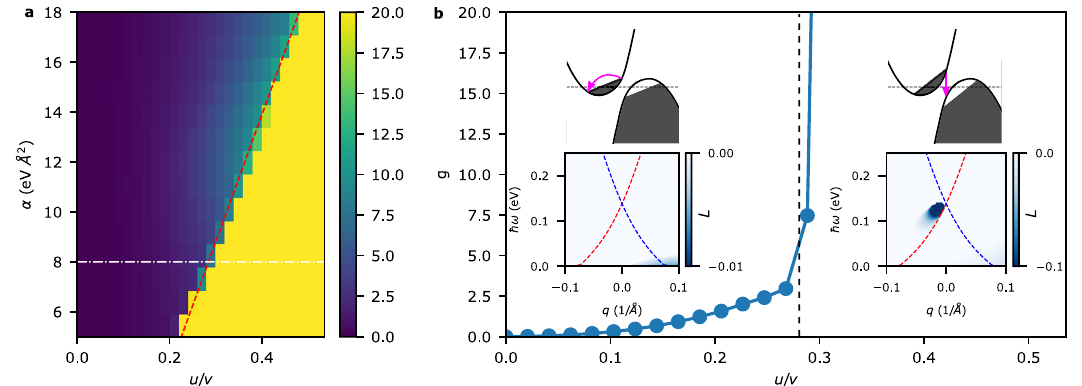
transitionsresponsiblefor u / v =0.165and u / v =0.33whicharebelowandabove u th respectively. The inset loss functions are scaled to only represent the regions over R ð q , ω Þ dqd ω ∣ . A black dashed which g ( α , u ) is integrated as de fi ned by g ð α , u Þ = ∣ L <0 L line is drawn at u th / v